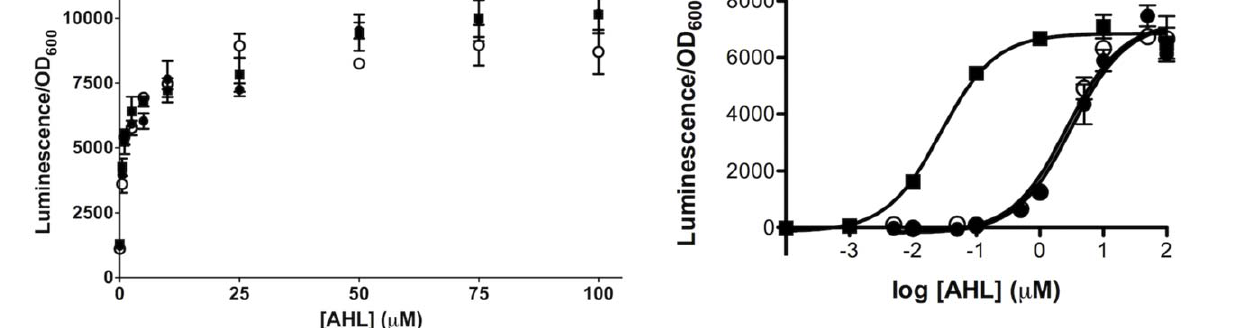
Figure 4. Autoinducer activity of a 1:1 mixture of 3a and 3b. Values shown are relative luminescence units normalized with respect to cell viability (OD 600 ). Square = 1:1 3a:3b . Closed circle = 3a . Open circle = 3b .